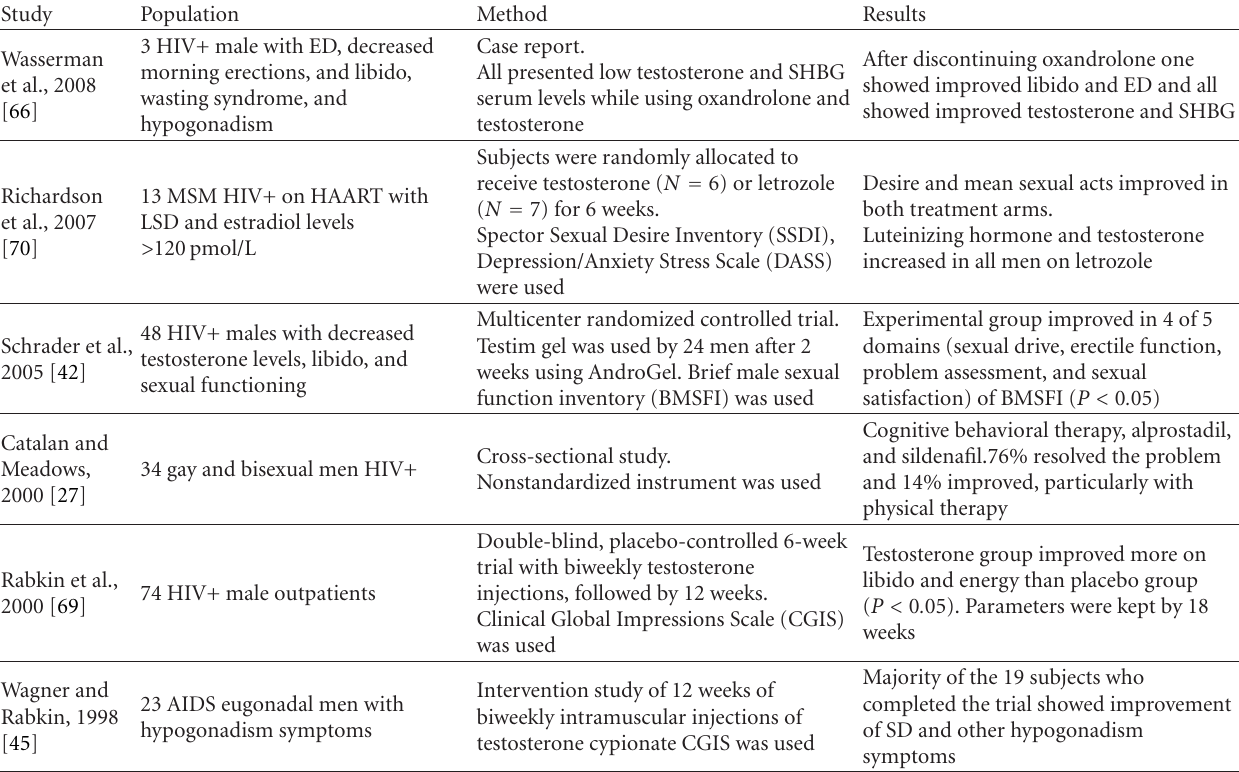
Table 2: Clinical management studies.